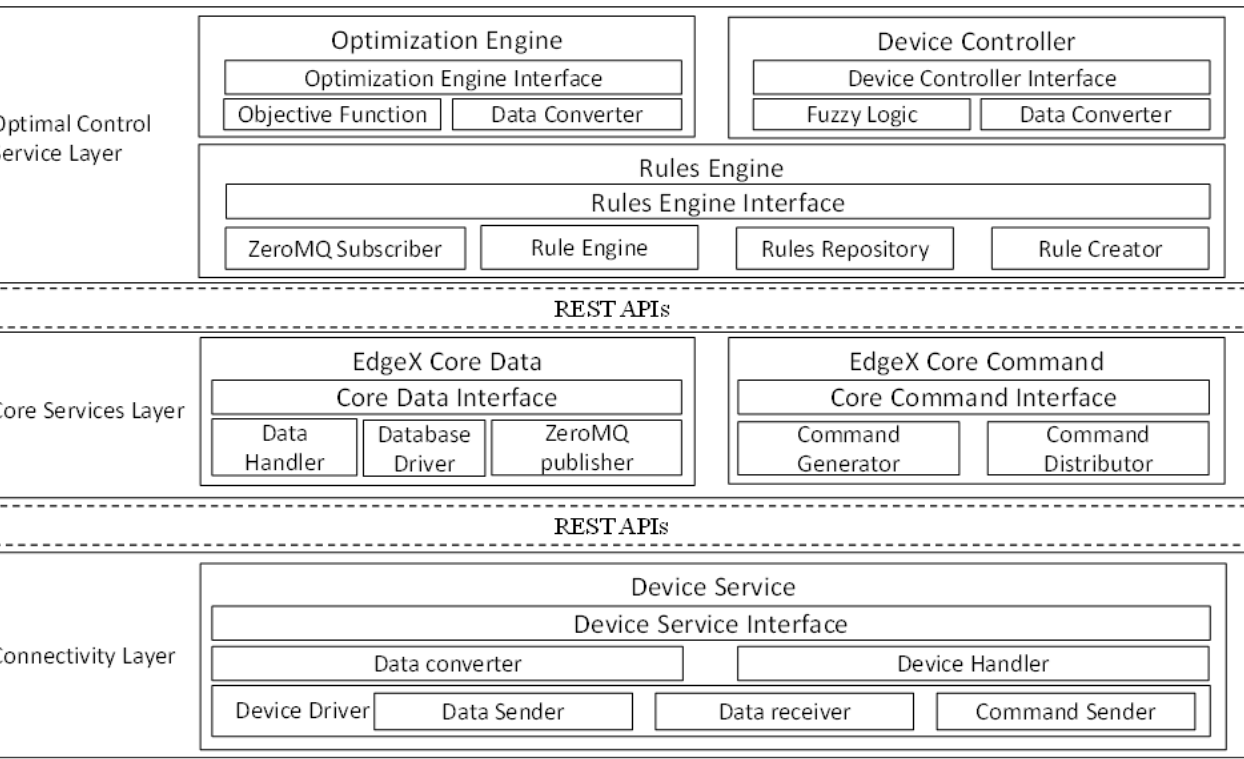
Figure 4. Development Model of the Intelligent Edge Computing Platform based on the Proposed Optimization Mechanism using